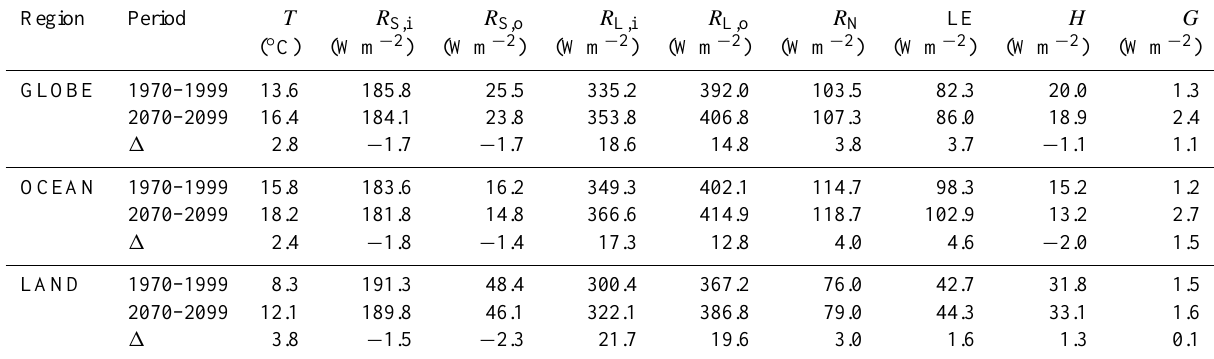
Table 2. Surface energy balance components for the globe, ocean and land simulated at the end of the 20th century (1970–1999, 20C3M) and projected to the end of the 21st century (2070–2099, A1B). Areas (globe, ocean, land) are listed in Table 1. T , near-surface air temperature; R S,i , incoming short-wave irradiance; R S,o , outgoing short-wave irradiance; R L,i , incoming long-wave irradiance; R L,o , outgoing